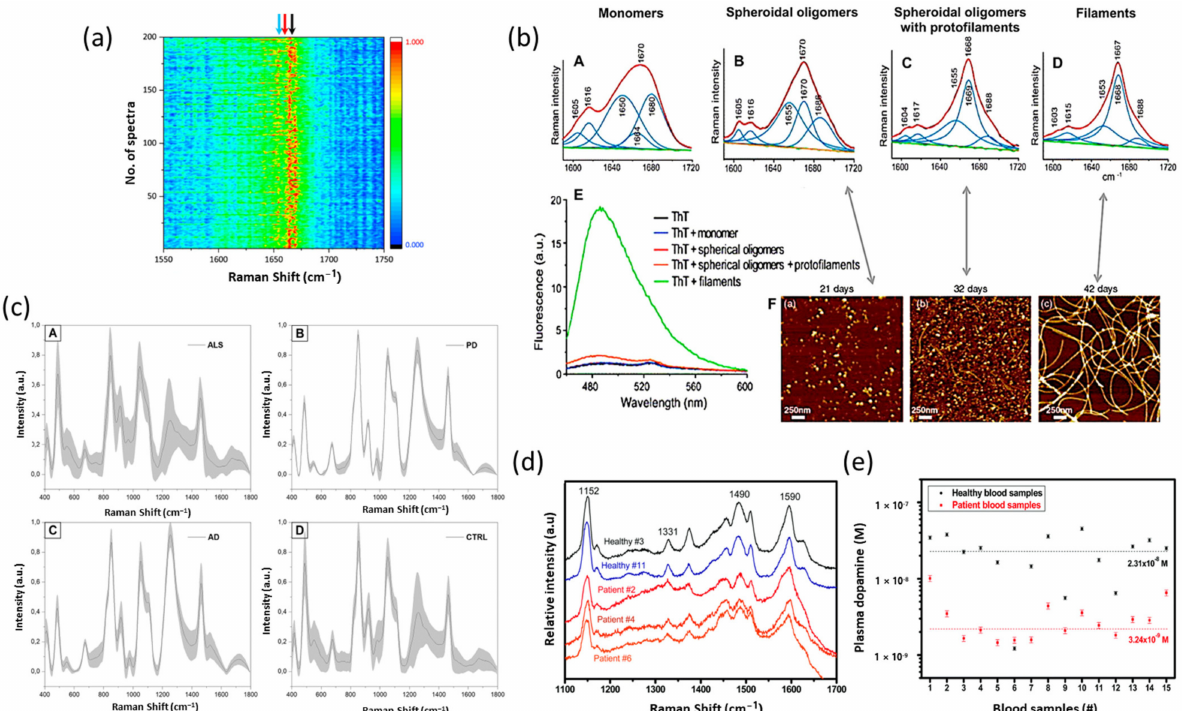
Figure 4. Applicability of different Raman techniques in diagnosis of PD. ( a ) Mapping of 200 SERS spectra of 1 µ M alpha-synuclein solution obtained from two AgNP-coated beads trapped at 20nm with 1s acquisition time. The color bar shows the normalized intensities from low (dark blue) to high (red). The blue arrow represents the amide I band at around 1653 cm − 1 , the red arrow represents the amide I band at around 1664 cm − 1 , and the black arrow represents the amide I band at around 1671 cm − 1 . Adapted with permission from Reference [54] © 2021 Nature Portfolio. ( b ) Structural changes of α -synuclein during aggregation. Raman spectra ( A – D ) reveal a narrowing of the amide I band with an increase in intensity of the peak ∼ 1670 cm − 1 , indicating an increase in β -sheet structures with aggregation. ( E ) ThT fluorescence spectra only show a large increase in fluorescence on